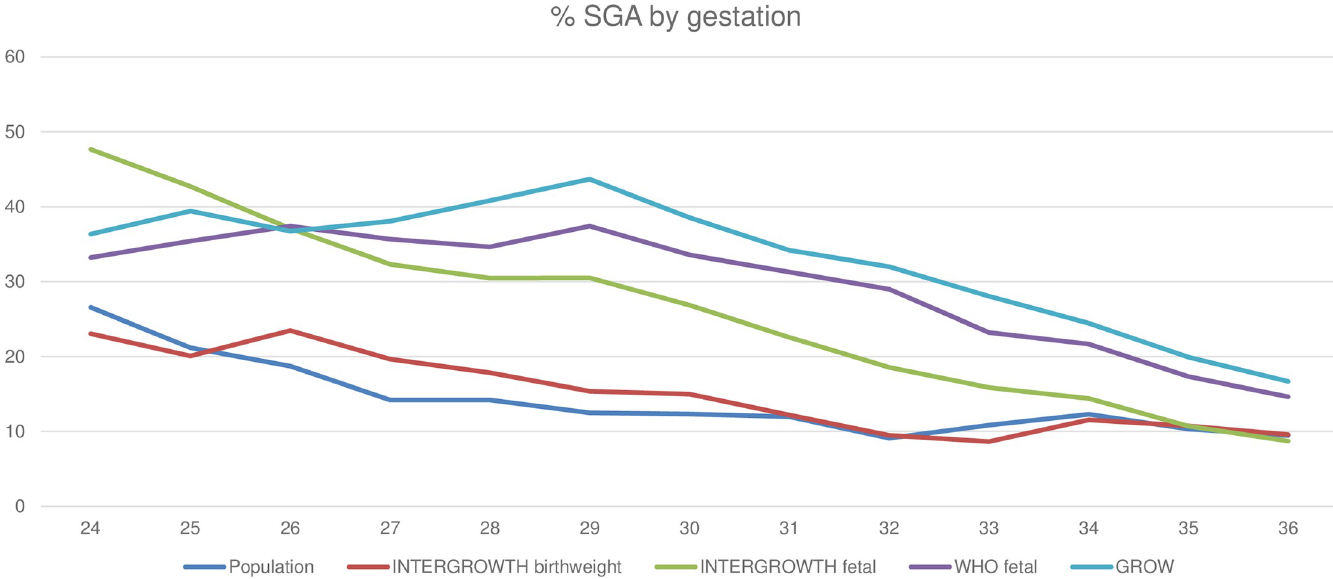
Fig 2. Proportion classified as SGA by each chart by week of gestation. GROW, Gestation Related Optimal Weight; SGA, small for gestational age.